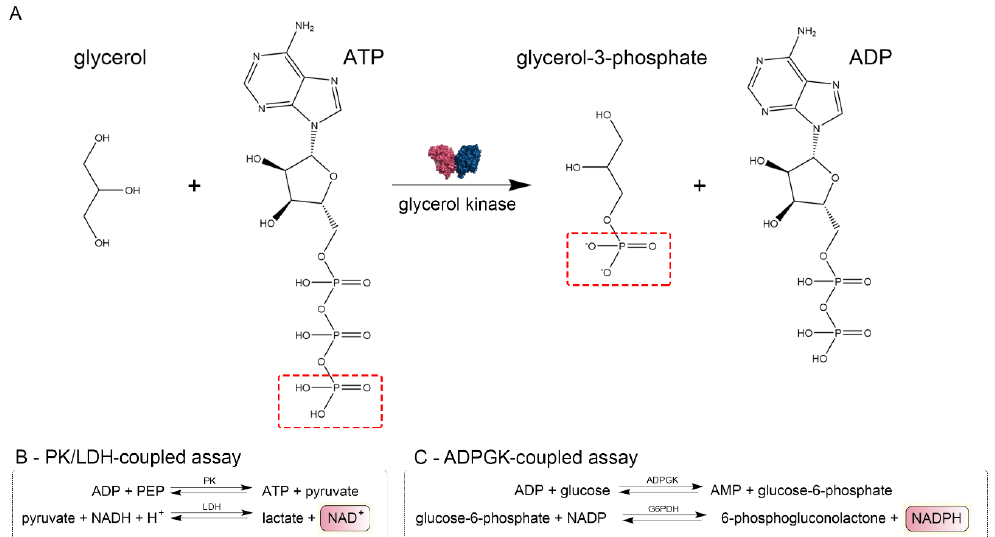
Figure 3. Schematic representation of enzymatic assays. ( A ) Glycerol kinase catalyzed reaction scheme and ( B , C ) methods used to assay CtGK activity.